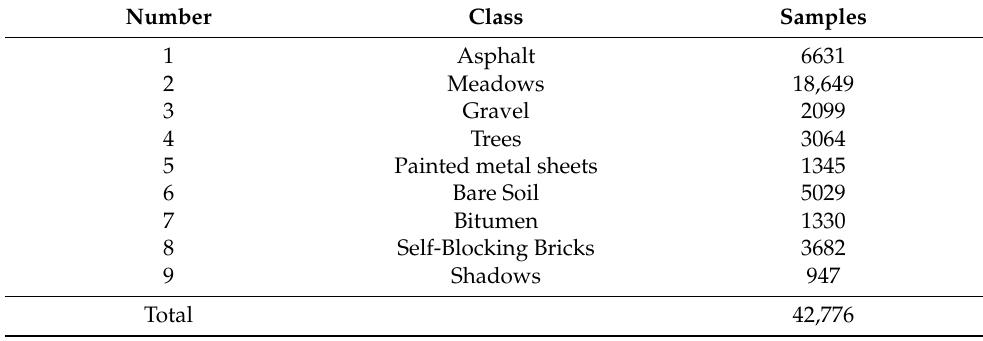
Table 1. Ground truth classes and their individual samples number for Pavia University.